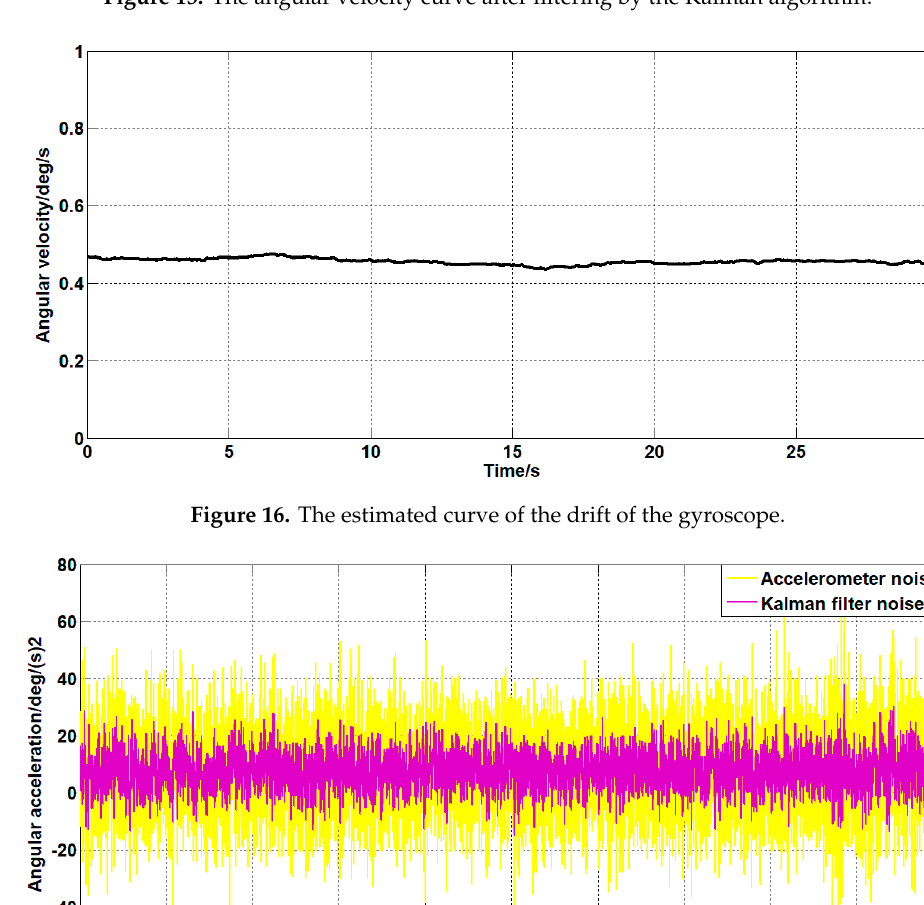
Figure 15. The angular velocity curve after filtering by the Kalman algorithm.